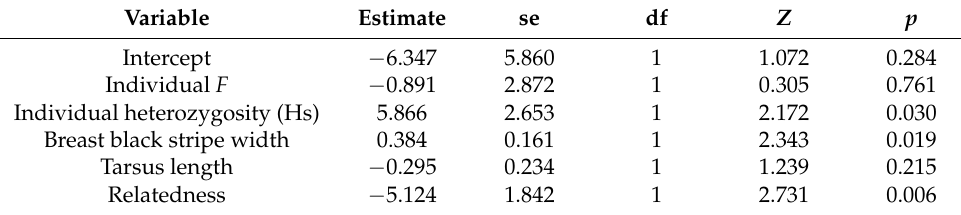
Table 5. Parameter estimates and p values of the fitted top GLMMs ( ∆ AICc <